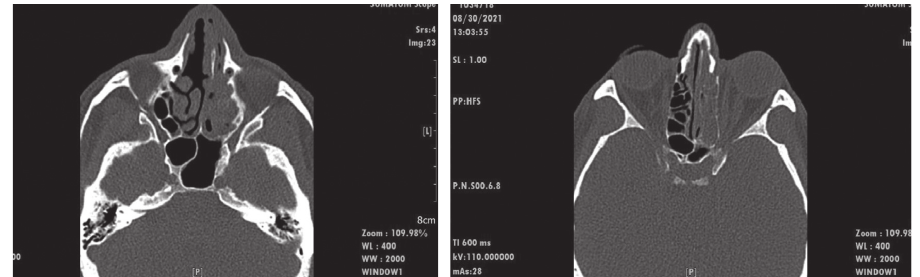
Figure 4: CTscan of sinuses (axial and coronal) revealed nasal septum is deviated to the left side. Opacity is seen in the left maxillary sinus and ethmoidal sinuses.